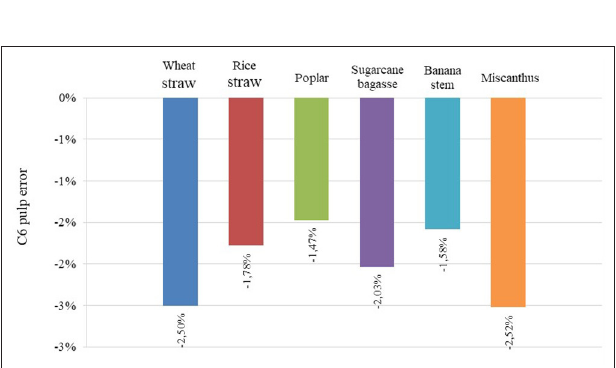
FIGURE 9 | Error in C6 pulp total flow vs. feedstock